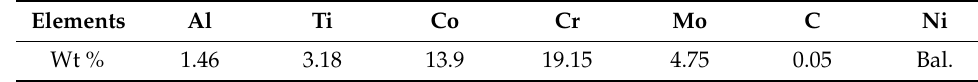
Table 1. The chemical composition of the Waspaloy.